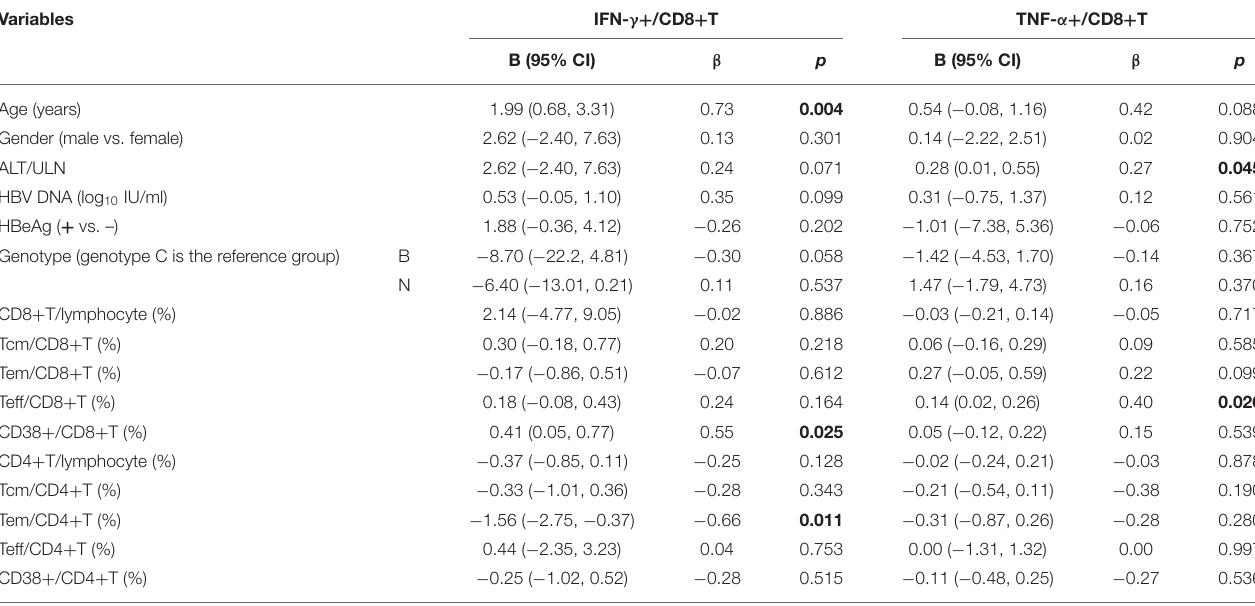
TABLE 3 | Factors associated with T-cell-secreting cytokines in multivariate linear regression analysis.